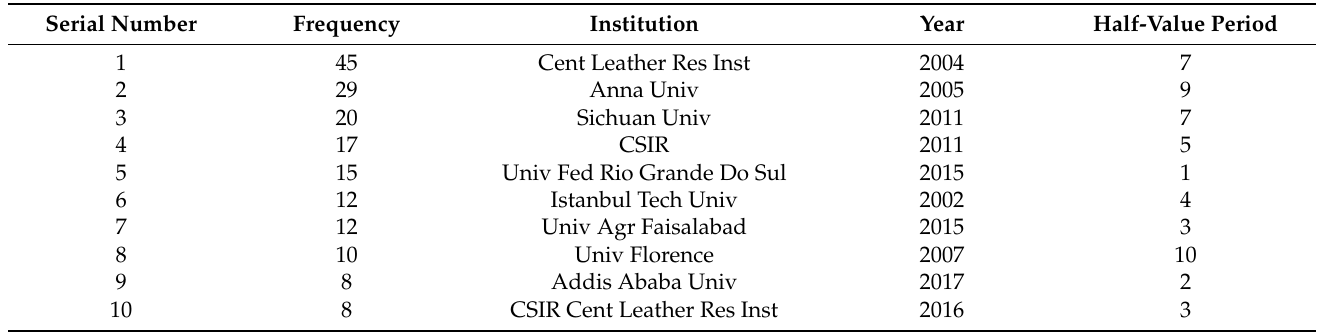
Figure 4. Institutions and their cooperation relationships with regard to tannery wastewater research. Scholars collaborate on research projects via co-authoring articles, which is a significant method of academic cooperation. Because of this, it is critical to know how academics communicate, including information on affiliations and countries, as well as other key author traits. Scholarly collaboration can help research progress. For example, the contributions of diverse students can lead to a better understanding of a particular research area. Table 3. Top 10 productive institutions in tannery wastewater research. This list summarizes the 10 most prolific institutions in the field of tannery wastewater research from 1991 to 2022. The Cent Leather Res Inst is on top of the list, followed by Anna Univ.